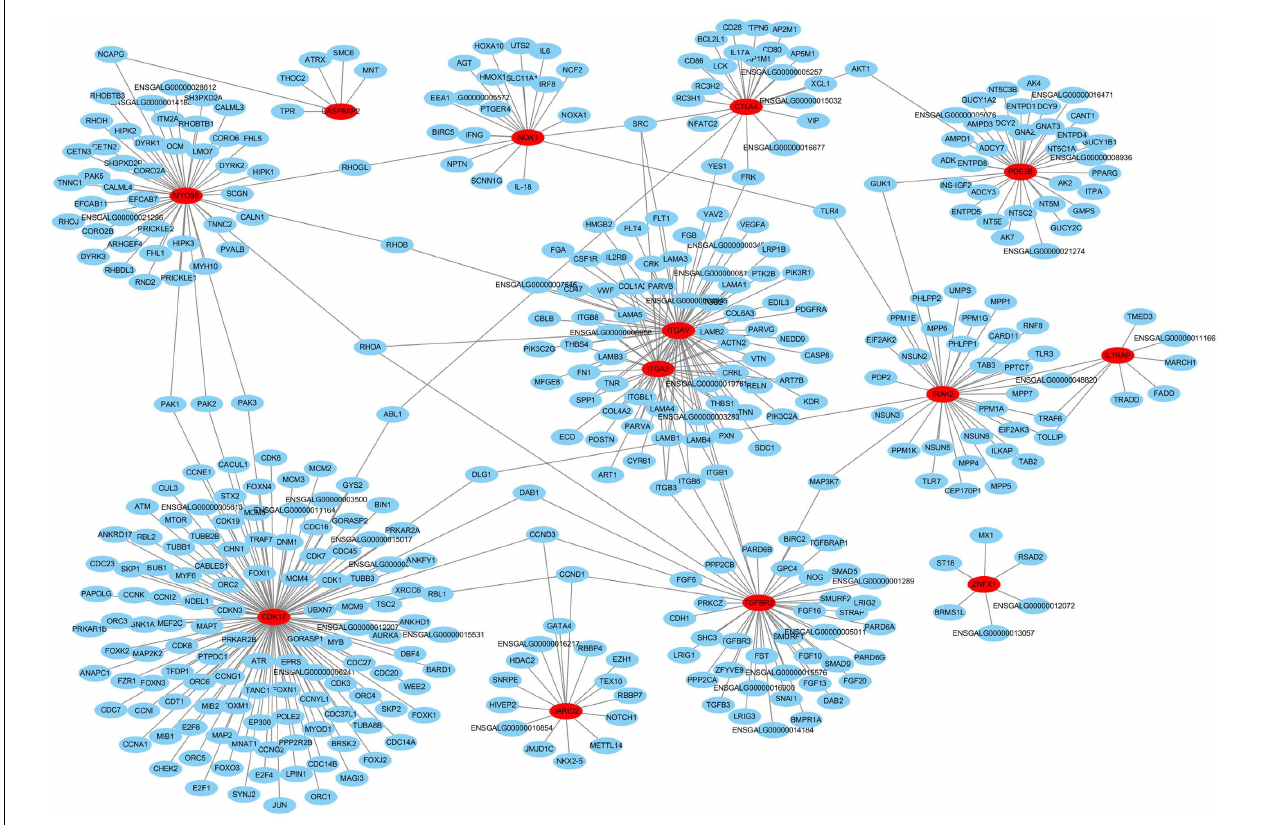
FIGURE 7 | The interaction network analysis of the 33 candidate DEGs based on the STRING database. In this network, red nodes represent hub genes, and lines represent potential